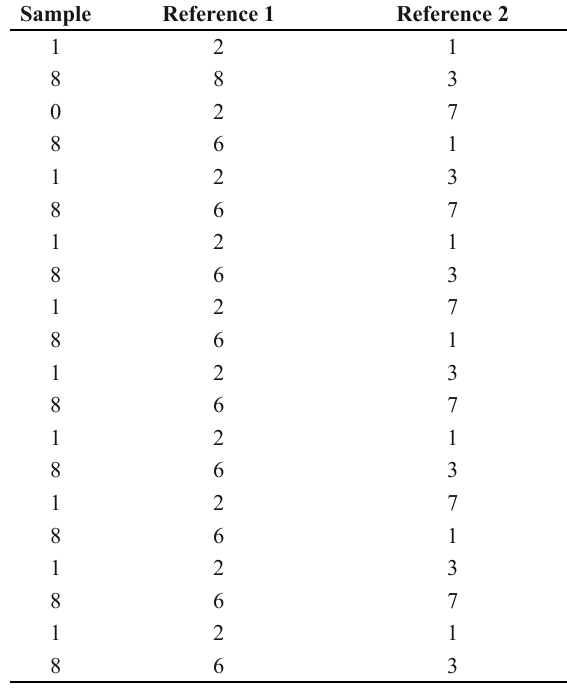
Figure 5 - Visual example of sequences used in morphological analysis. Values of the example of the process of recognition of sequences.